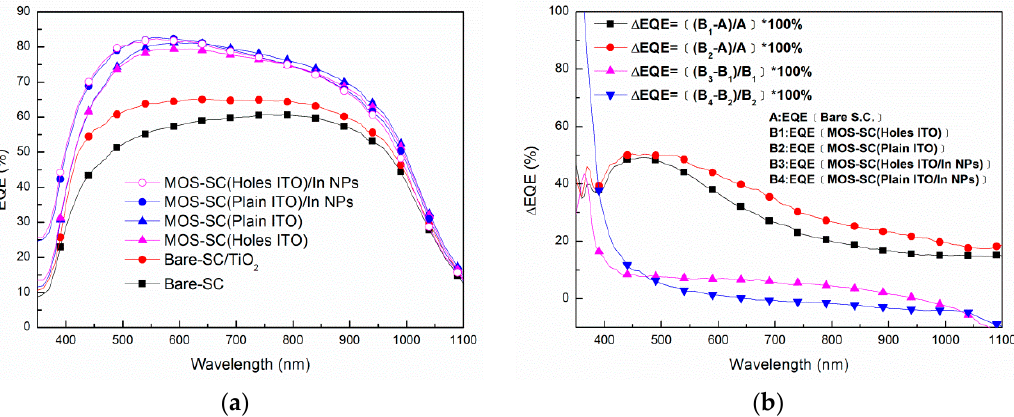
Figure 3. ( a ) EQE response of all solar cells tested in this study; ( b ) EQE enhancement can be attributed to anti-reflective properties and plasmonic light scattering.